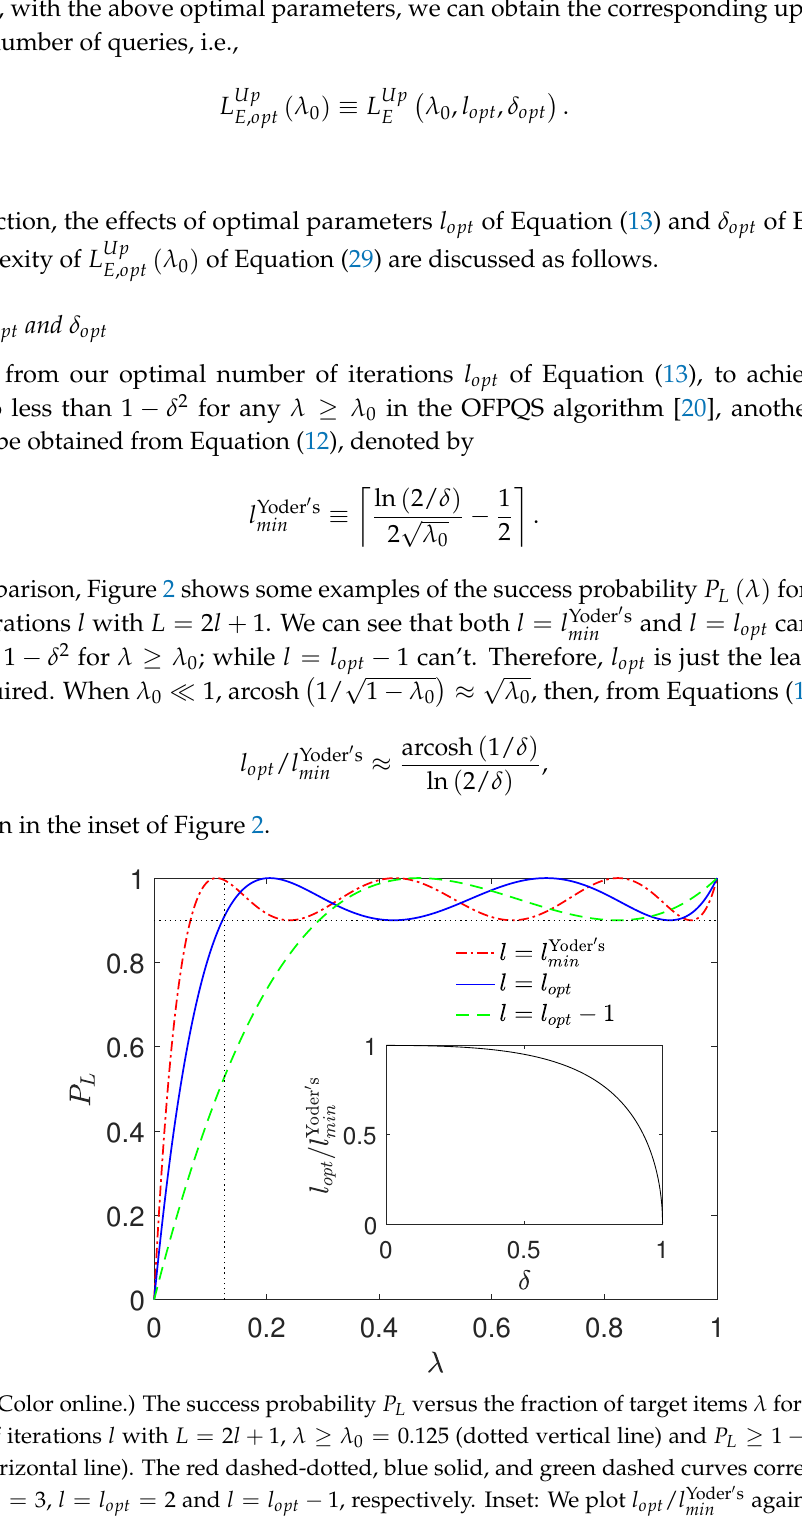
against δ with min